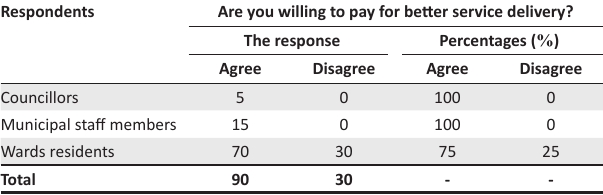
TABLE 4: Summary of the respondents on their willingness to pay for municipal services.